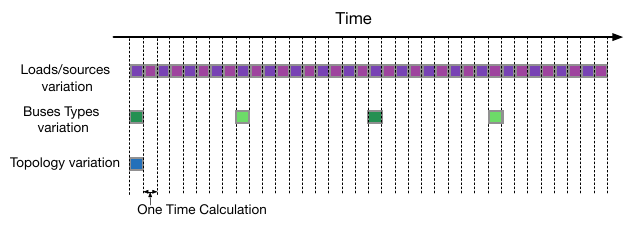
Figure 6. Power system analysis without the proposed technique.